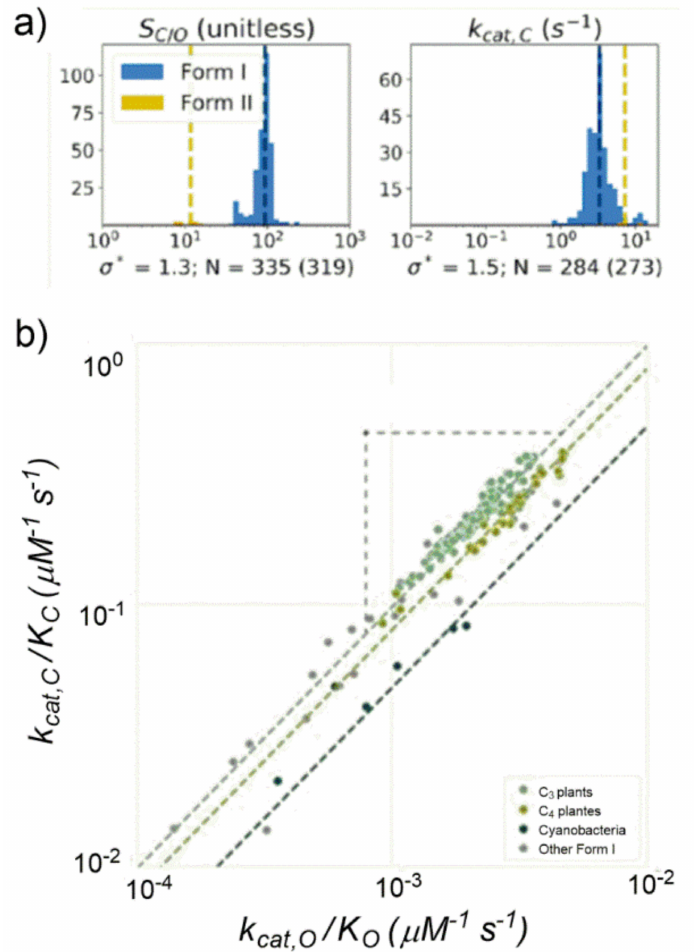
Figure 18. ( a ) Histograms of Rubisco kinetic parameters S C/O and k cat,C experimentally determined for several hundred species at 25 ◦ C and pH = 8. The values of kinetic parameters are reported along the X -axis (log scale) and the number of data points is reported along the Y -axis. The parameter distributions for Form I Rubisco are represented in blue while the parameter distributions for Form II Rubisco are represented in yellow. Dashed lines give the median value. N is the number of Form I Rubisco for which S C/O and k cat,C parameters have been considered and σ * is the multiplicative standard deviation of Form I values; ( b ) diagram showing k cat,C /K C and k cat,O /K O are strongly correlated on a log − log scale (R = 0.94; p < 10 − 10 ). Light green point refers to Rubisco from C3 plants; mustard points refer to Rubisco from C4 plants; deep green points refer to Rubisco from cyanobacteria. (Figure 18 from ref. [51], adapted and used by permission of American Chemical Society (copyright ©